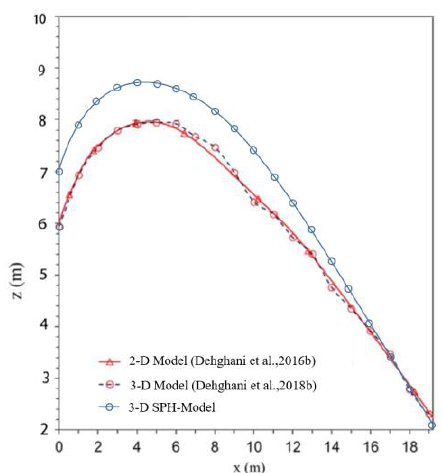
Figure 6. The maximum height of the model in this example is compared with the two-dimensional and three-dimensional models of Dehghani et al. (2016,2018) [40,41].